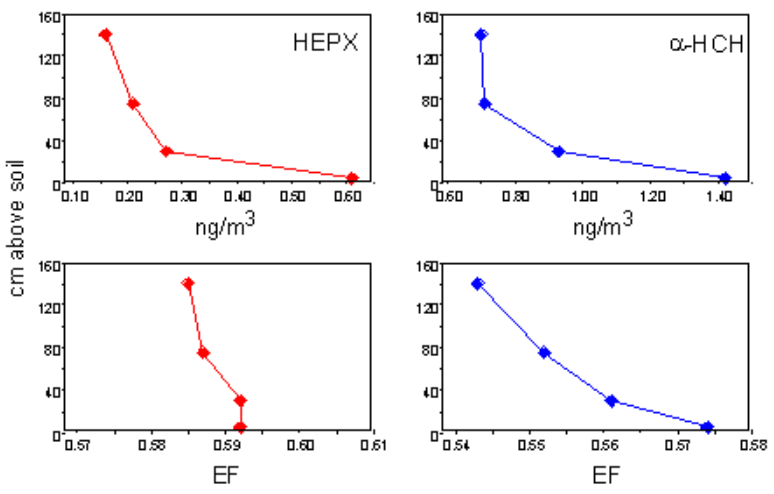
FIGURE 2. Profiles of OCP concentration (upper) and EF (lower) in air above an agricultural field in the Fraser Valley, British Columbia. Data from Finizio et